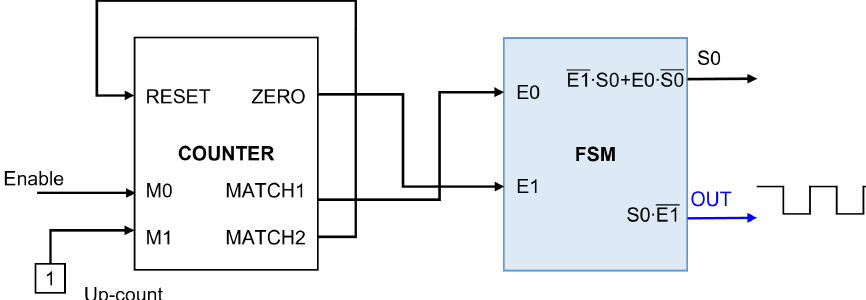
Figure 7. Counter and FSM for clock generation.